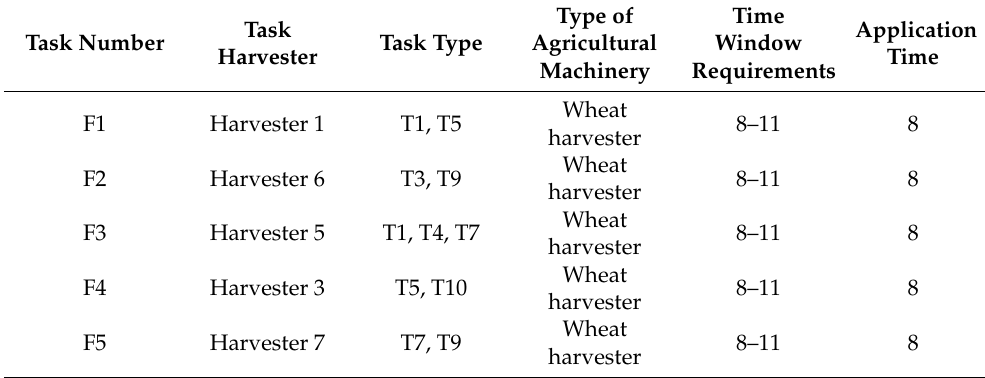
Table 8. Instance task information.